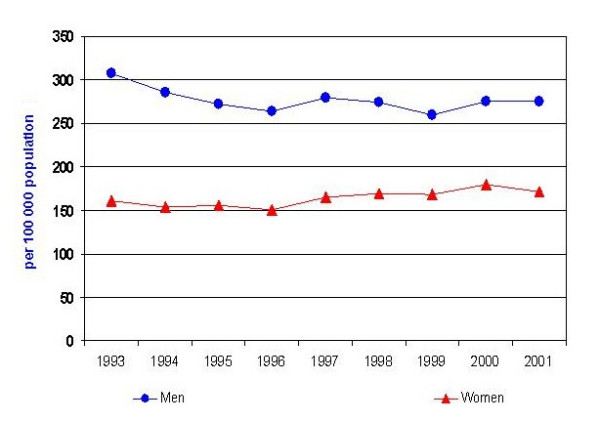
Age-adjusted, gender-specific incidence of cancer, all sites combined, in Arkhangelskaja Oblast.